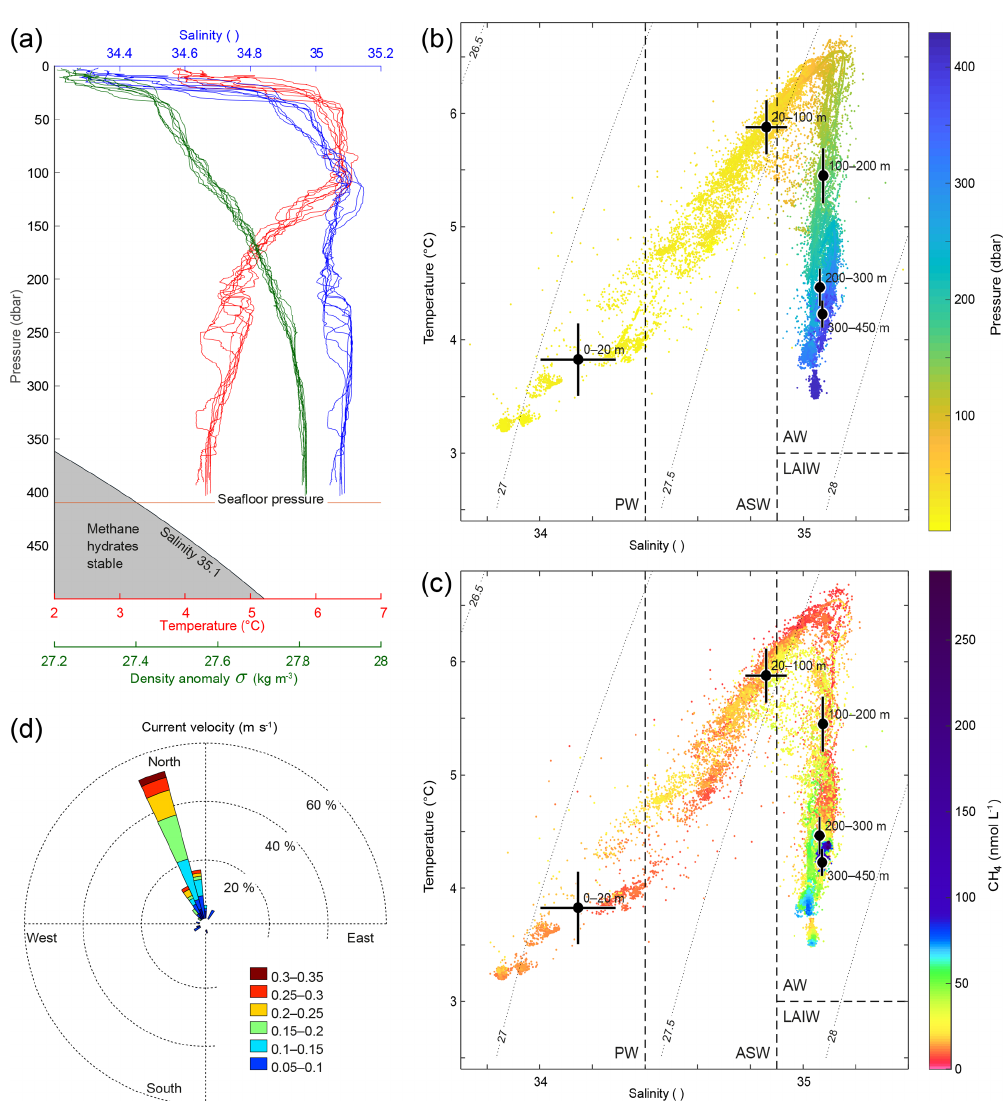
Figure 2. Hydrography during the survey. (a) CTD casts 1617–1626 showing temperature (red), salinity (blue), and density anomaly (green) calculated with Gibbs seawater package (McDougall and Barker, 2011). (b) Temperature and salinity diagram coloured by pressure (dbar). Grey curved lines in the background indicate isopycnals (constant density ( σ ) lines). AW indicates Atlantic Water, PW is Polar Water, ASW is Arctic Surface Water, and LAIW is Lower Arctic Intermediate Water. Water mass definitions are described in the text. Black dots indicate the mean water properties for the different layers and crosses indicate the corresponding standard deviations. (c) Temperature and salinity diagram coloured by CH 4 concentrations (nmolL − 1 ) measured with the MILS. Black dots depict average temperature and salinity at water depth intervals and the error bars indicate the corresponding standard deviations. (d) Water currents inferred from inclination of flare spines (Veloso et al., 2015) with a mean bubble rising speed of 23cms − 1